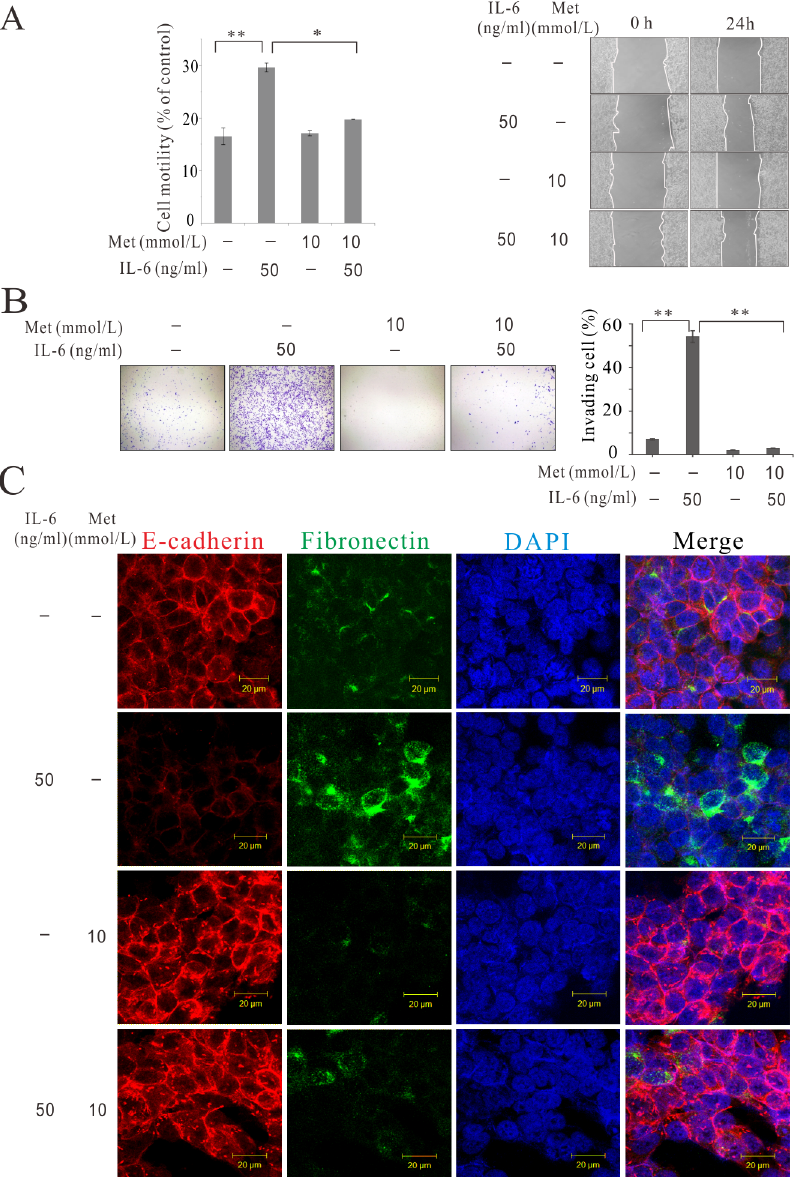
Fig 5. Metformin inhibited IL-6-induced EMT in the human colon cancer cell line. (A) Migration assay for colon cancer cells incubated with IL-6 and metformin (HCT116). (B) Invasion assay for colon cancer cells (HCT 116). (C) Immunofluorescence confocal microscopy analysis of HCT 116 colon cancer cells treated with IL-6 and metformin. Met, metformin. (cid:3) p < 0.05, (cid:3)(cid:3) p < 0.01.